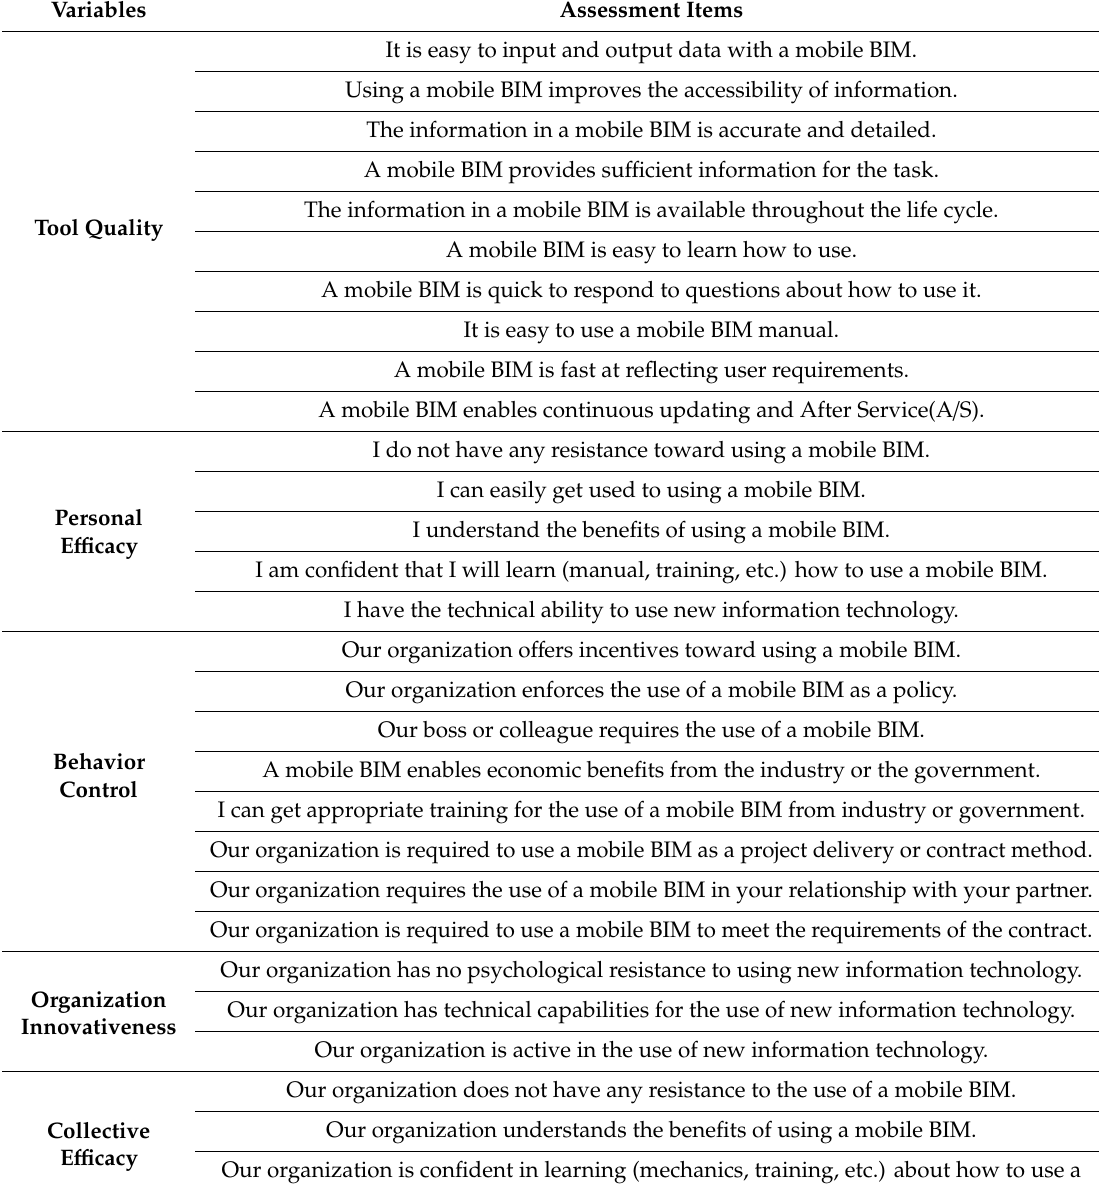
Table 5. Assessment items of external variables for Mobile-BIM